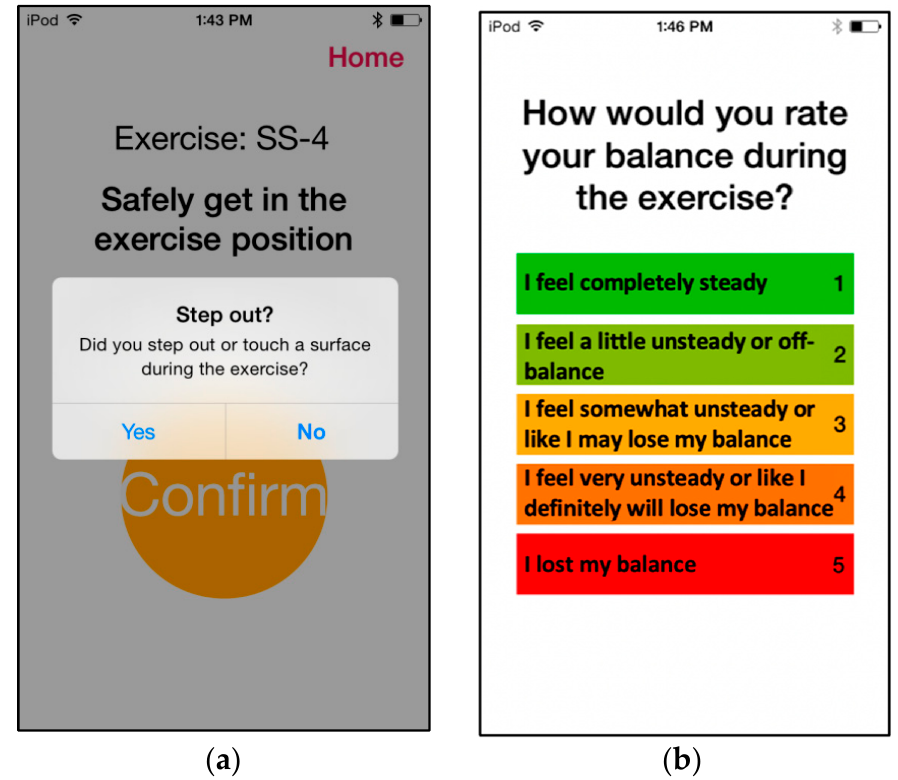
Figure 4. Screenshots showcasing the prompts participants responded to during home-based balance and coordination training sessions. After each repetition of a home-based exercise, participants were prompted ( a ) to report whether they stepped out during the exercise, and ( b ) to indicate a self-rating on the VAS 1–5 scale.